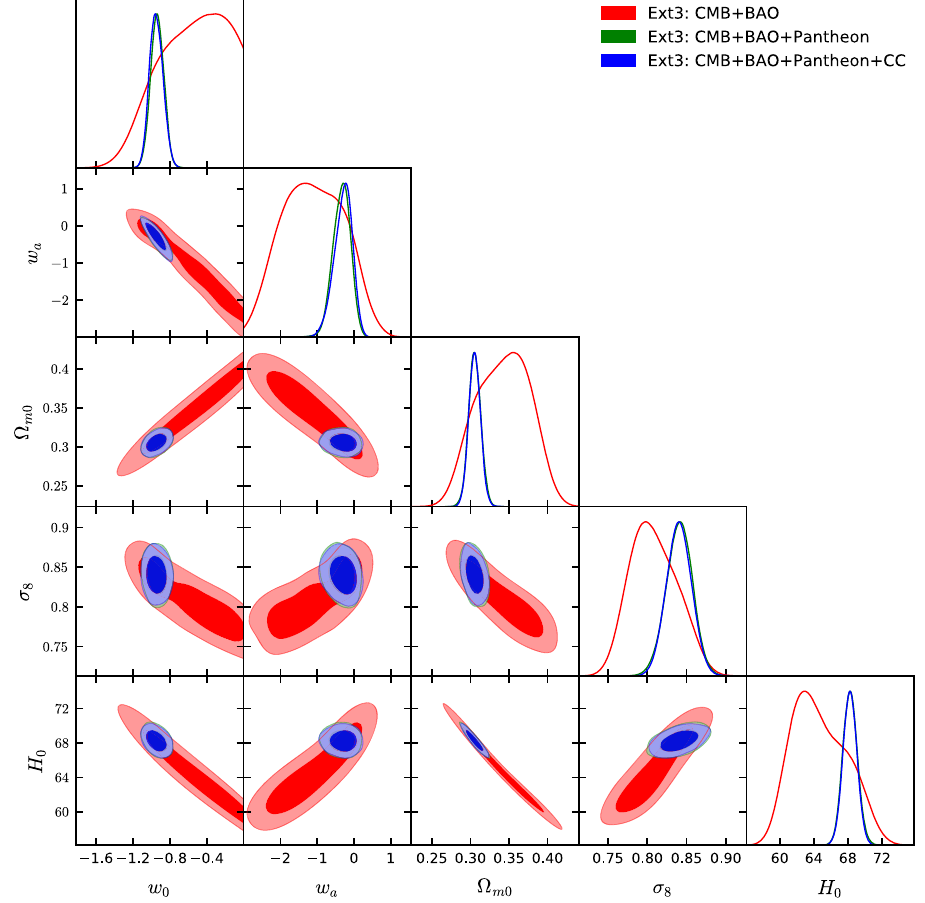
Fig. 9 68% and 95% CL contour plots for various combinations of the model parameters of the Ext3 of (9) have been shown for different observational combinations. The figure also contains the one dimensional marginalized posterior distributions for the parameters shown in the two dimensional contour